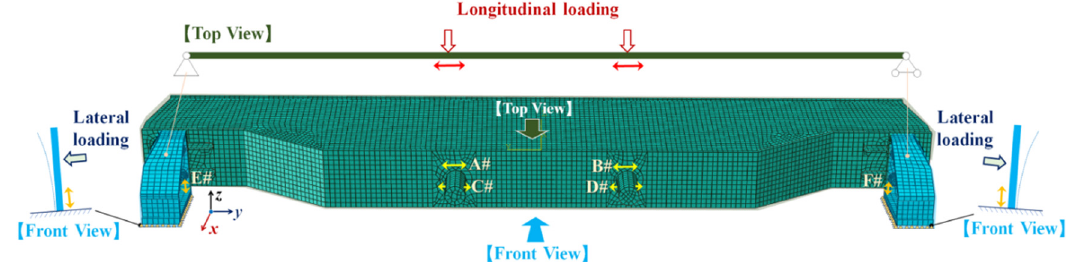
Figure 4: Mechanical model of the stop structure in longitudinal and horizontal